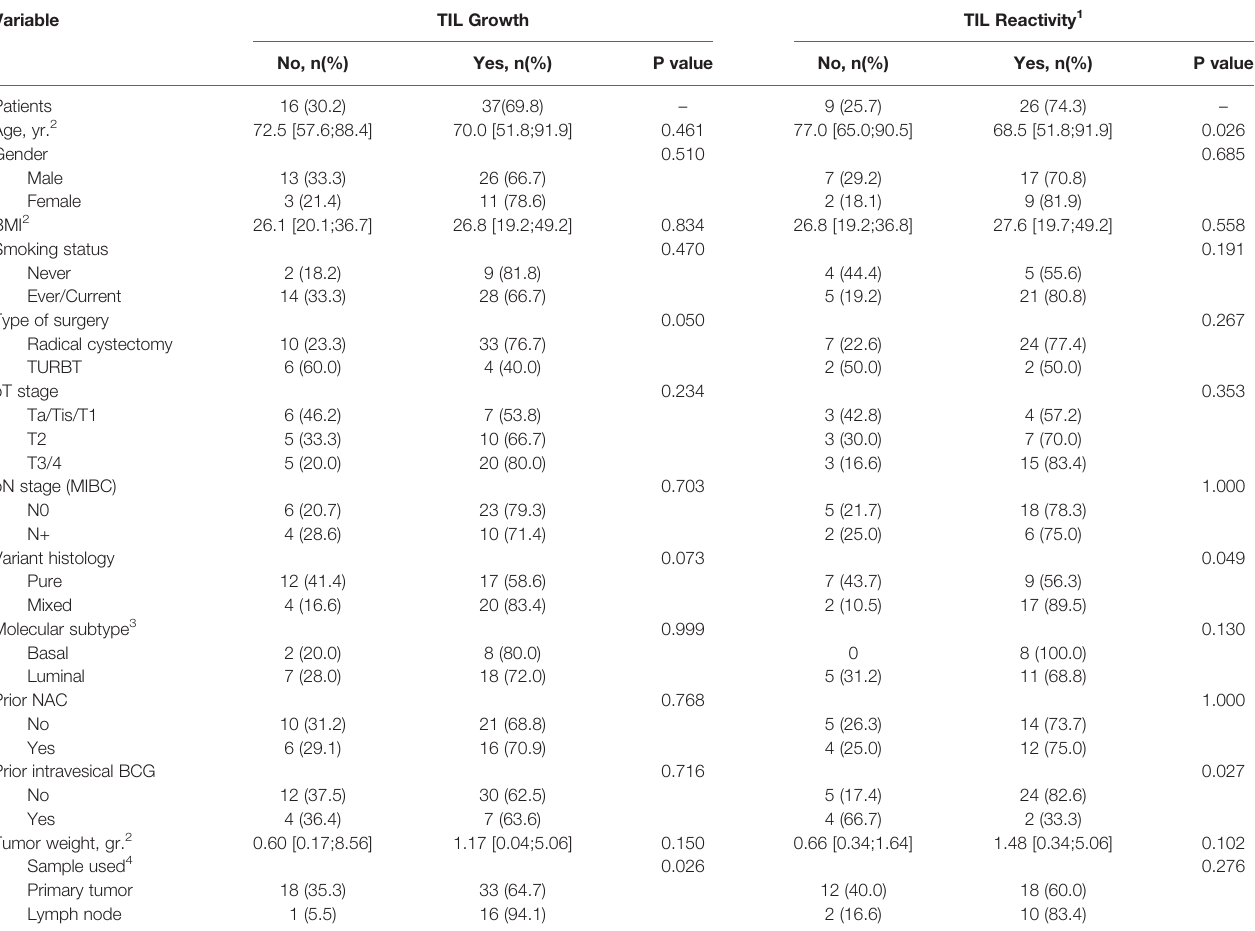
TABLE 3 | Factors affecting growth and reactivity of TIL harvested from primary tumors and/or lymph nodes in 53 patients. Variable TIL Growth